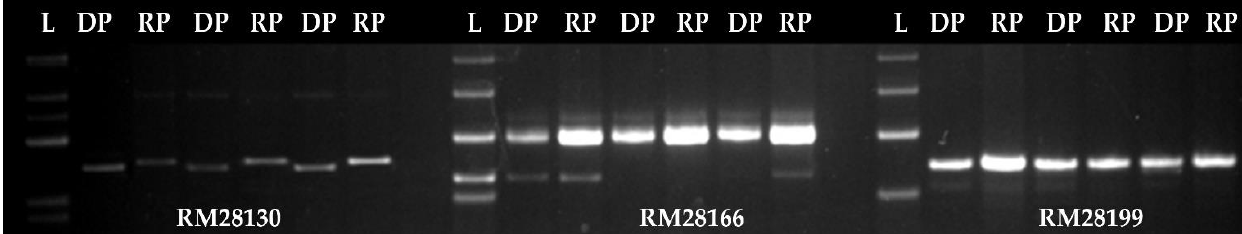
Figure 1. Representative gel picture showing polymorphism of foreground markers. RM28130 provided the best contrast between Pusa 44 and IR90019-22-28-2B. L: ladder; RP: recurrent parent, Pusa 44; DP: donor parent, IR90019-22-28-2B. RP and DP were replicated 3 times.